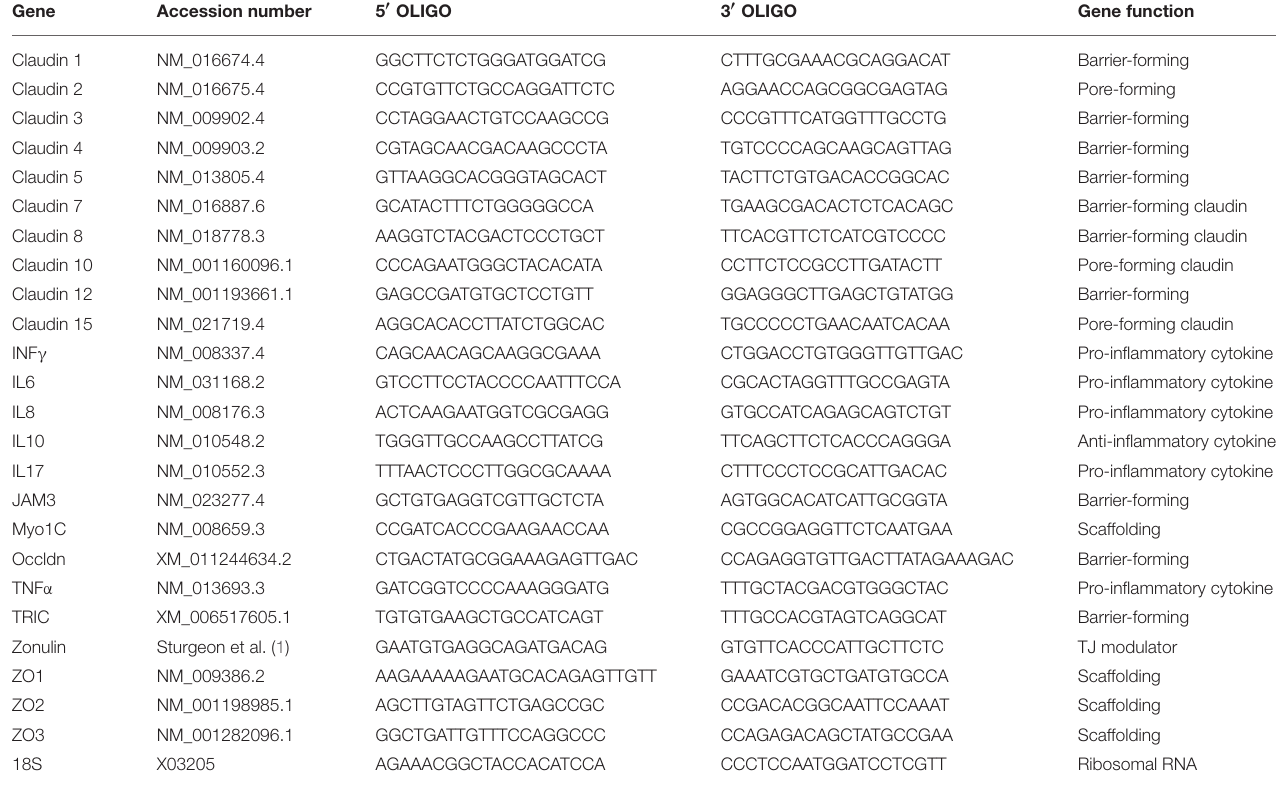
TABLE 1 | List of all primers and FASTA accession numbers of the genes analyzed by real time qPCR analysis. Gene Gene